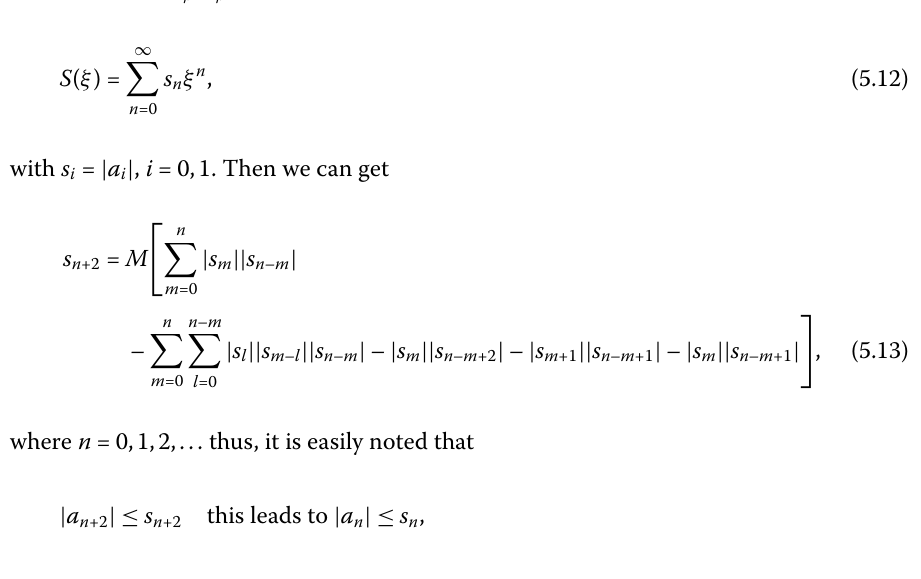
where M = max { 3 k , 2 a ,12 dp 2 } , ρ = bp 2 + c ( q 2 + r 2 ). Now, consider another power ρ ρ